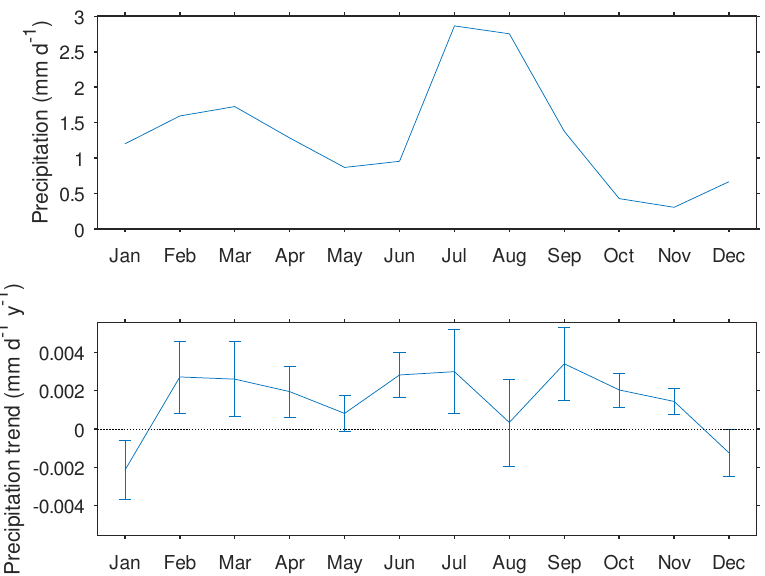
Figure 3. Top : mean precipitation over the Indus basin by month from GPCC, 1891–2016. Bottom : trend in precipitation by month from GPCC (with standard errors),